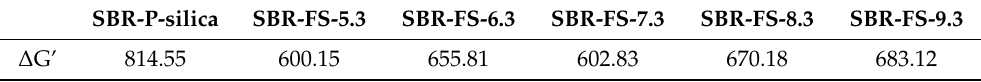
Table 5. The delta storage modulus ( ∆ G’) of SBR composites filled with P-silica and FS-SiO 2